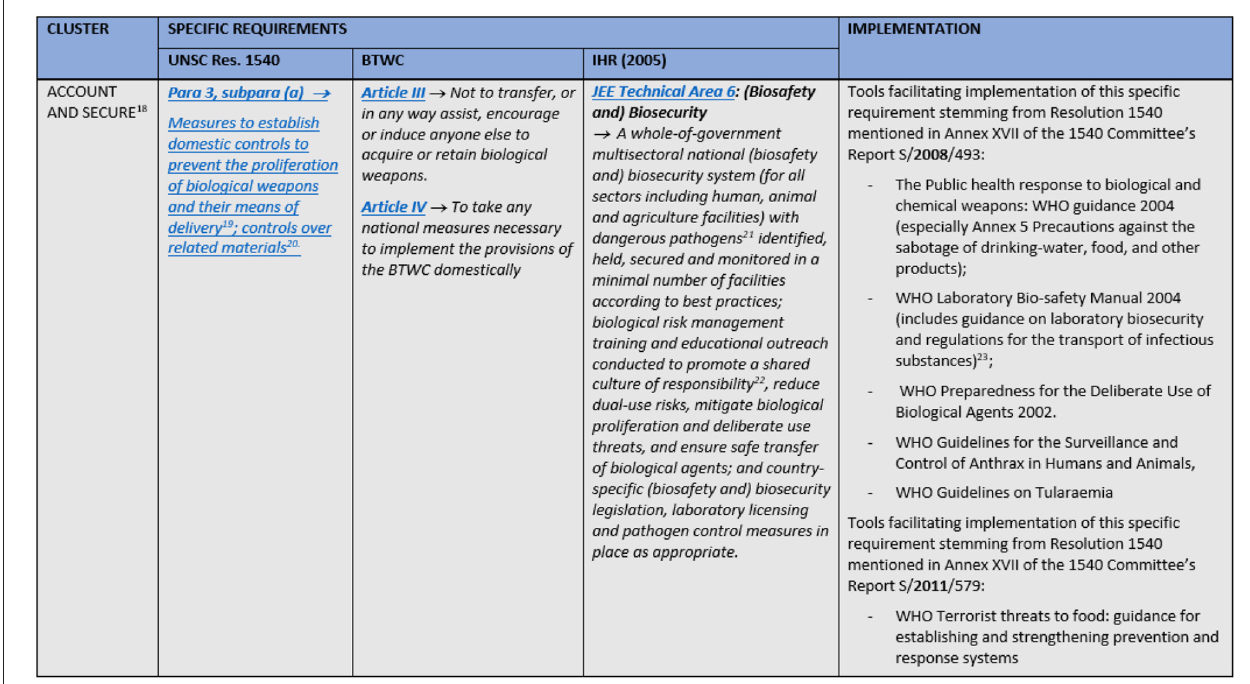
FIGURE 1 | A short section of the matrices with obligations stemming from UNSCR1540, BTWC, and IHR and an implementation